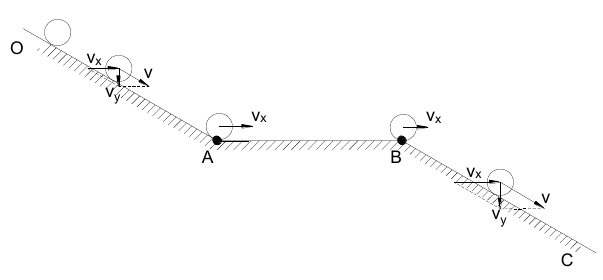
Figure 13. Change of rockfall velocity along a slideway with a plat- form (length of the vector indicates the absolute velocity